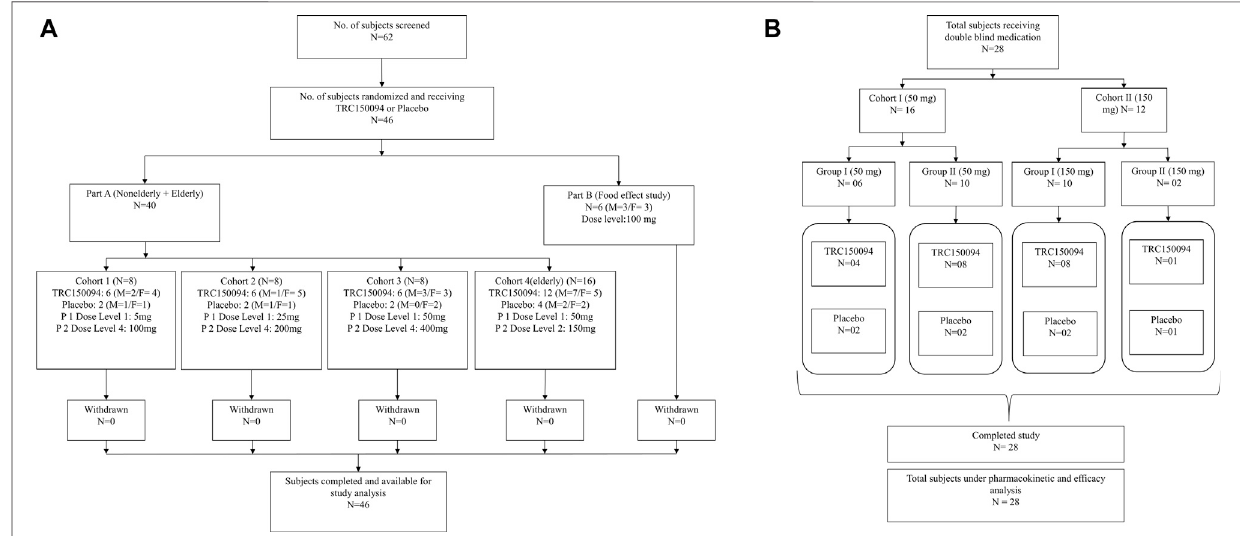
FIGURE 1 | Study design and subject disposition in (A) single ascending dose study and (B) multiple ascending dose study.